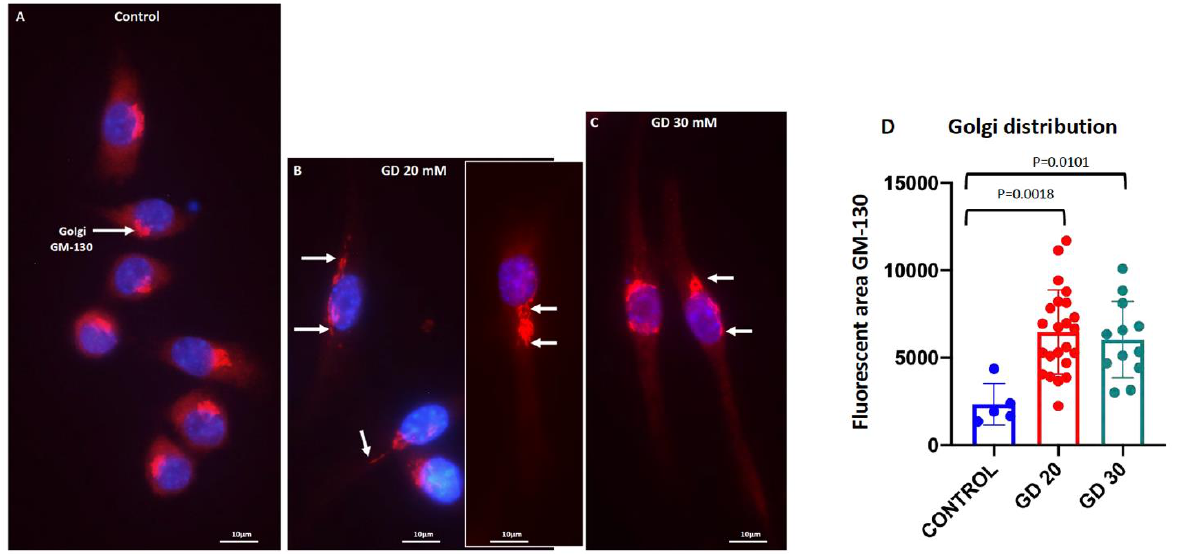
Figure 9. Dotarem caused a redistribution of the Golgi complex. ( A – C ) Images of RAW 264.7 macrophages untreated (control) and treated with 20 and 30 mM Dotarem (GD20, GD30) immunostained with the Golgi marker GM-130 (red) antibody. Nuclei were stained blue with DAPI. All are merged images. ( A ) In the untreated control cells, the Golgi formed a compact structure located to one side of the nucleus (arrow). ( B , C ) In the Dotarem-treated cells, the Golgi was distributed within the larger area in the vicinity of the nucleus and/or around the nucleus (arrows). Panel ( B ) is combined from two separate images. ( D ) The graph shows that the differences (calculated from three experiments) in the Golgi distribution between the control and the Dotarem (GD)-treated cells were statistically highly significant.